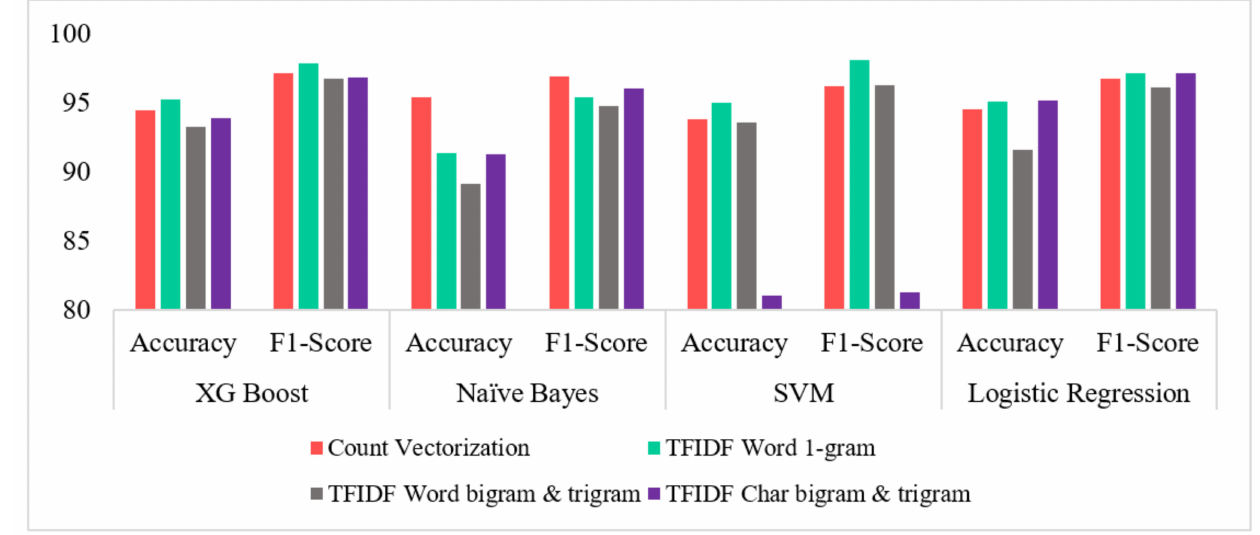
Figure 8. Performance comparison of traditional machine learning techniques on Wikipedia Attack dataset.